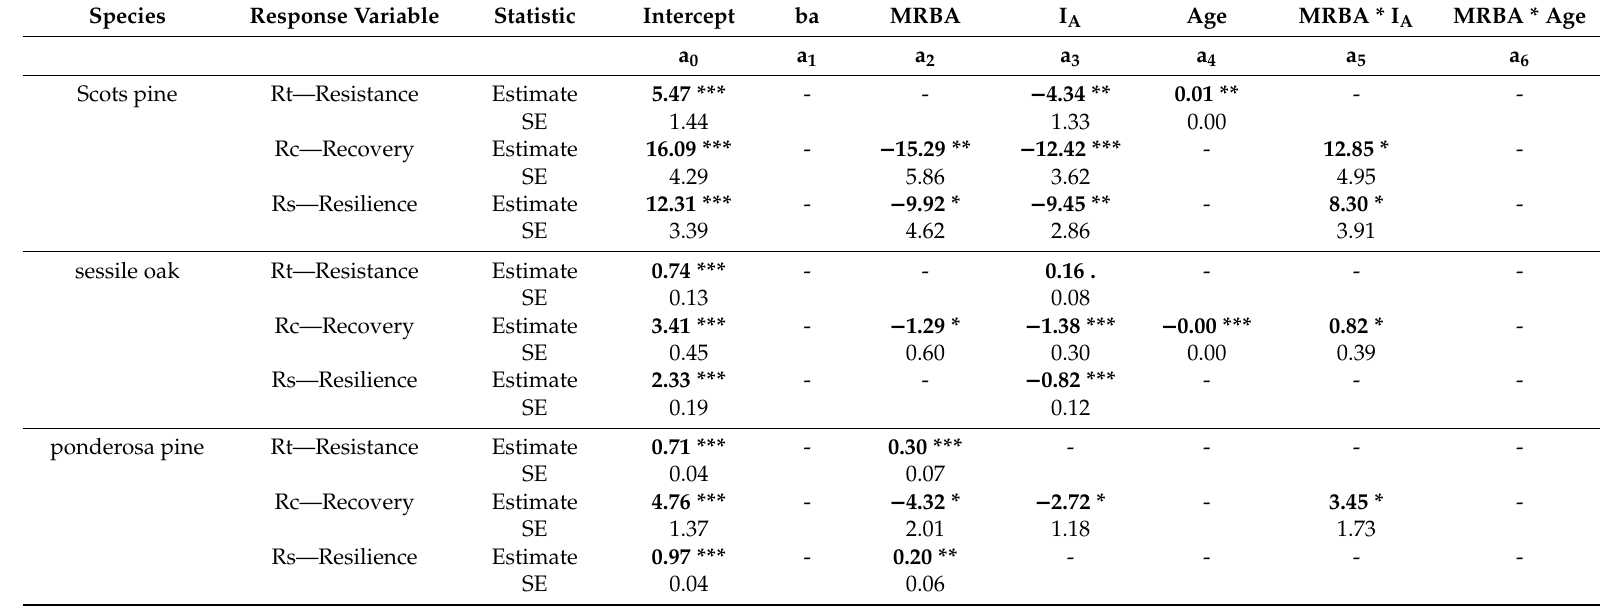
Table 3. Results of the linear mixed-e ff ects model regressions from Equation (8). We test the e ff ect of tree basal area ( ba , cm 2 ), mean relative stand basal area ( MRBA ), Global Aridity Index ( I A ), stand age ( Age , yrs ) and corresponding interactions with MRBA ( MRBA * I A , MRBA * Age ) on the studied species-specific tree drought responses ( Rt , Rc , Rs ). The number of observations was always n = 229 for Scots pine, n = 225 for sessile oak and n = 359 for ponderosa pine. Bold values are significant at level p < 0.001 (***), p < 0.01 (**), p < 0.05 (*), p < 0.1